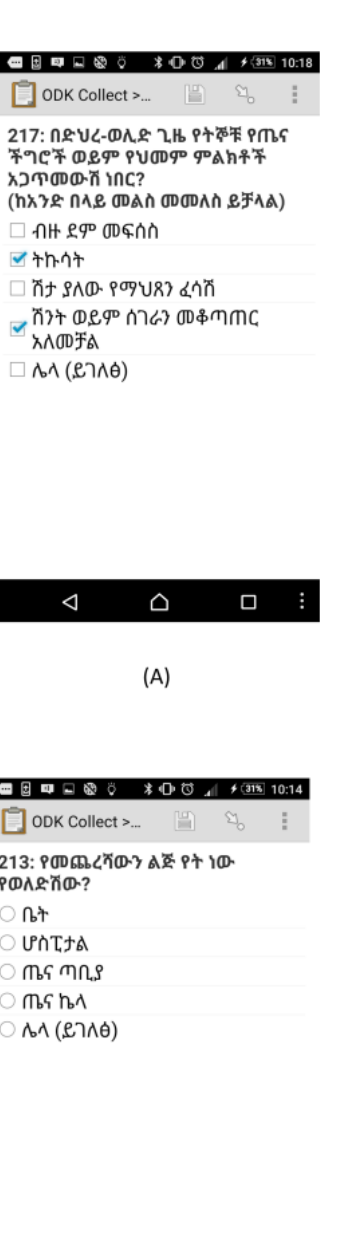
Figure 1. Screenshot examples of the type of questions; multiple choices (A), number (B), single select (C), and date (D) presented in the electronic data capture tool used for the survey in Dabat Demographic and Health Surveillance site in June 2016, northwest Ethiopia. Translation of the Screen: (A) 217: Which of the signs of pregnancy complications or danger sign of pregnancy have you encountered during postnatal period? bleeding, fever, vaginal gush of fluid, incontinency, and other (describe); (B) 204: Birth weight for the last child (if it was measured); (C) 213: Where did you give birth for your last child? home, hospital, health center, health post, and other (please mention it here); and (D) 218: When was the last child